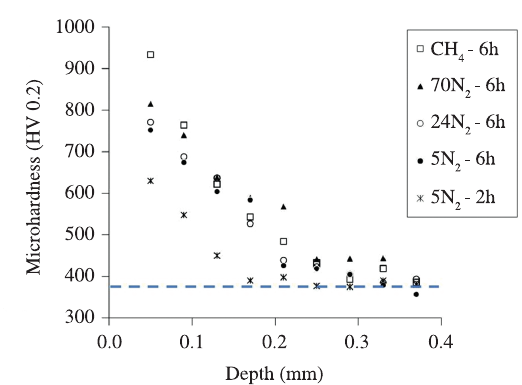
Figure 8. Hardness profile of nitrided samples.